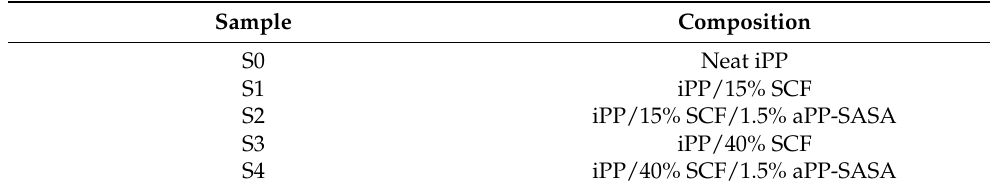
Table 1. Identification of the samples studied in this work.